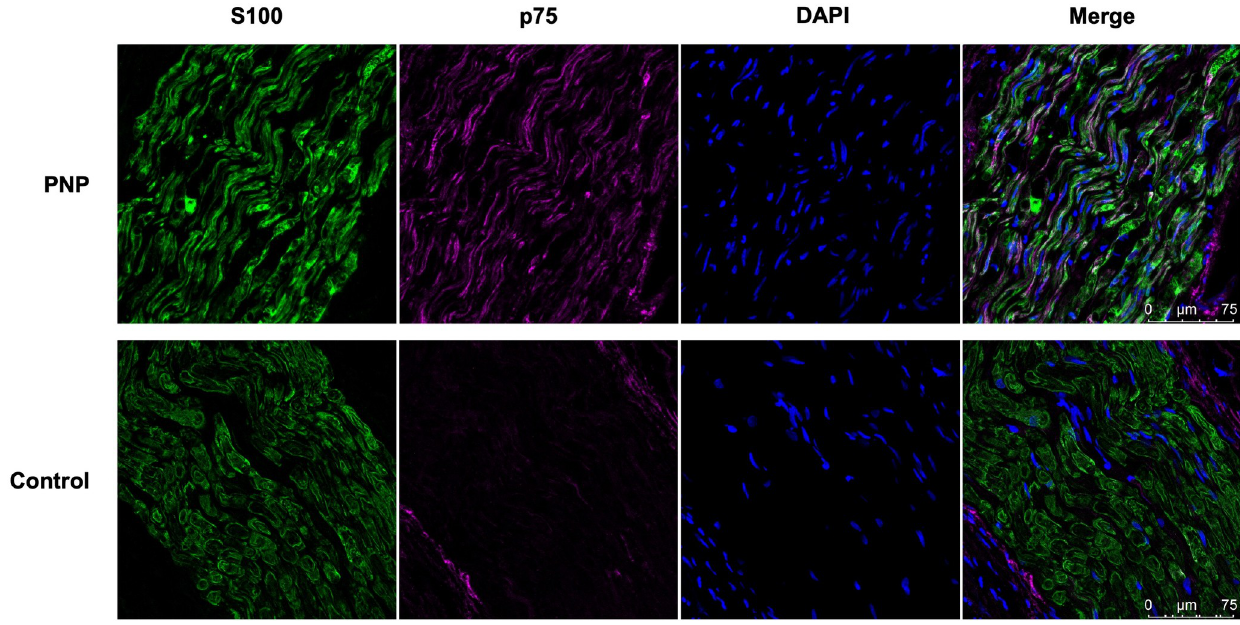
Fig 4. p75-immunoreactive Schwann cells in polyneuropathy. S100 positive Schwann cells (green) and p75-immunoreactive Schwann cells (purple) were stained in sural nerve biopsies. Cell nuclei were stained with DAPI (blue). Imaged at 63x magnification under equal exposure times; scale bar: 75 μ m. PNP : polyneuropathy